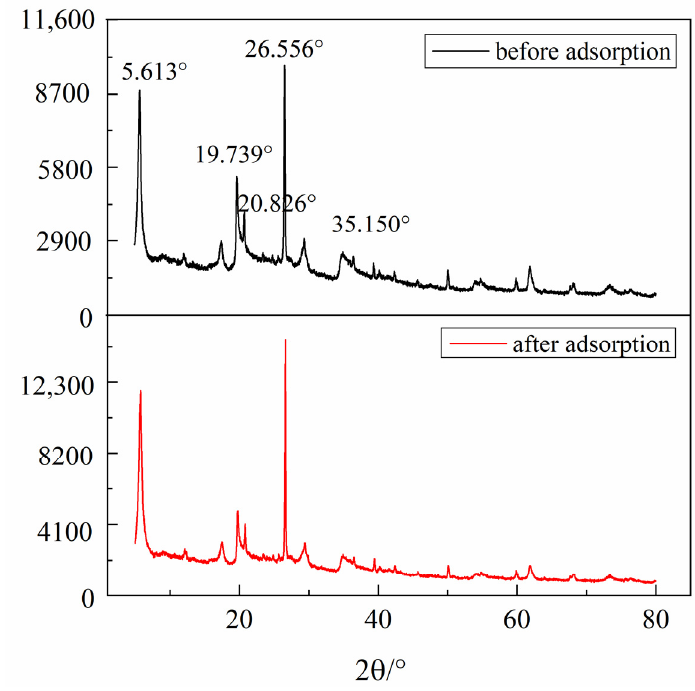
Figure 8. XRD spectra of montmorillonite before and after welan gum adsorption.